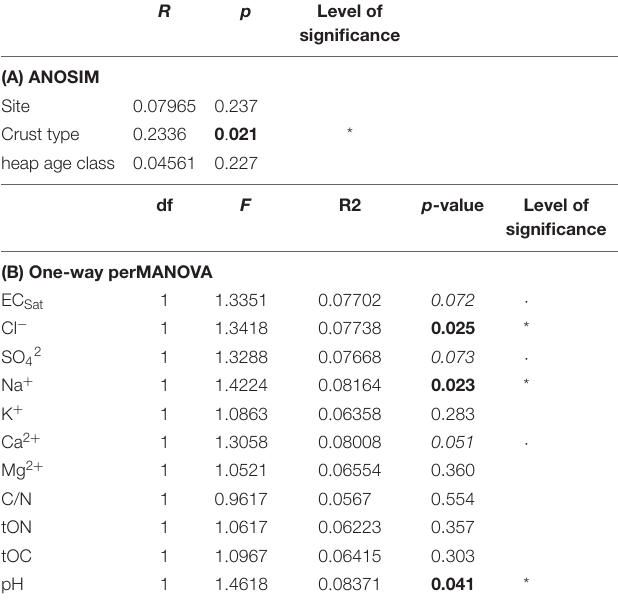
TABLE 4 | (A) Analyses of similarity to reveal significant differences of the present algal isolate composition between the sites, biocrust type (young, established) and potash tailings pile age classes. (B) Influence of abiotic conditions on algal isolate composition tested by PerManova; given are: F-value, R2-value (which corresponds to the variation in the isolate composition explained by the respective factor) and level of significance: *p < 0.05 (values in bold), · p < 0.1 (values italic); df: degrees of